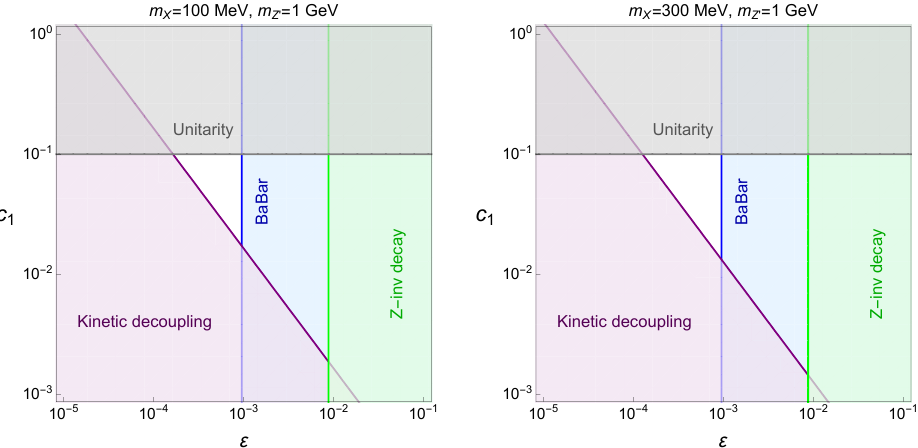
Figure 4 . Allowed parameter space for vector SIMPs with a Z 0 portal in the " and c 1 plane, for (cid:12)xed values of DM and Z 0 masses. We show the bounds from unitarity (brown), kinetic equilibrium (purple), the invisible width of the Z boson (green) [65] and BaBar monophoton+MET (blue) [66]. Here, we took N f (cid:11) Z 0 = 1 in eq. (2.18) for Z -boson invisible decay